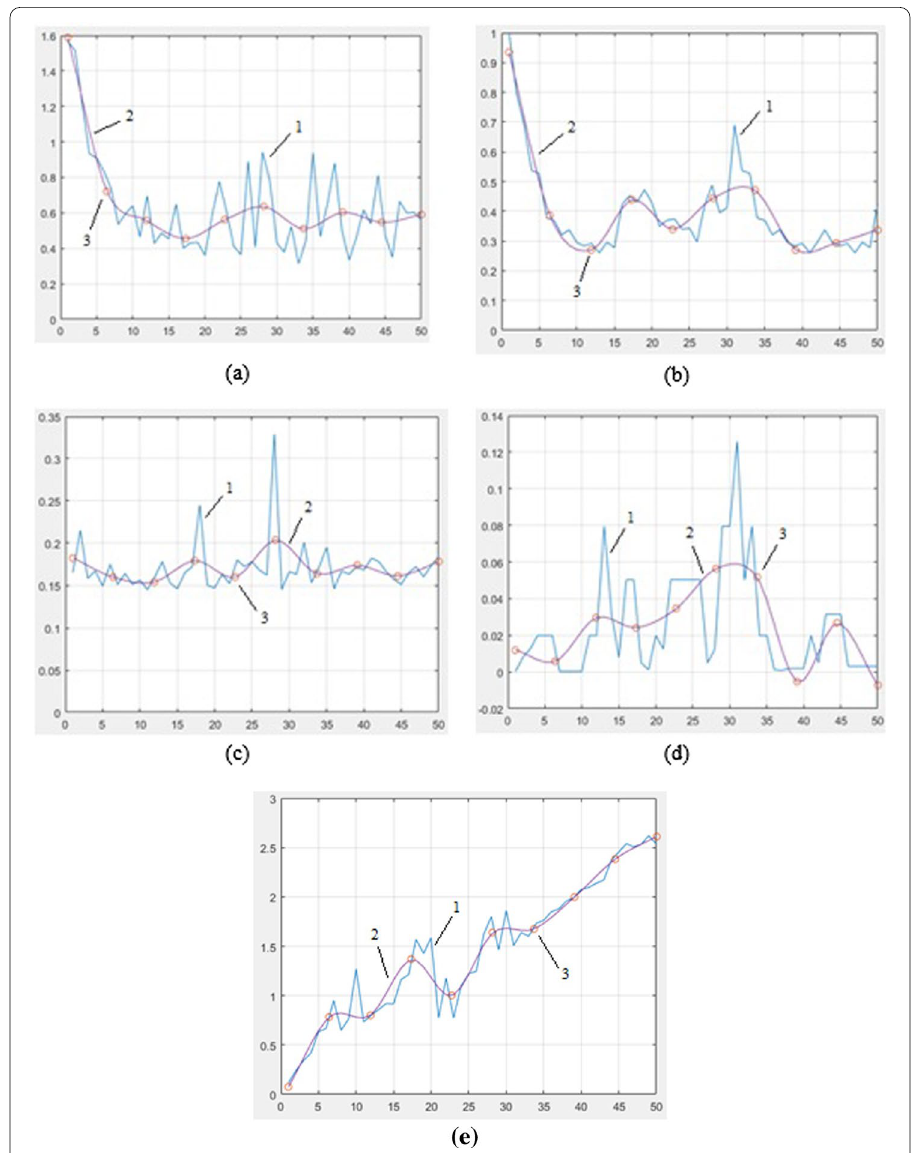
Fig. 8 Input stream speed approximation: 1—curve of measured values; 2—curve of approximated values; 3—merging nodes ( a input stream speeds; b output stream speeds; c delays; d powers of signal; e video file loading